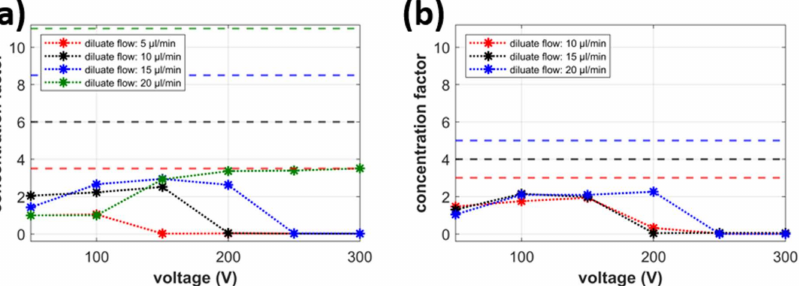
Figure 4. Concentration factor (solid lines with markers) and theoretical concentration factor (dashed lines); ( a ) voltage dependence ( V C = 2 µ L/min), ( b ) voltage dependence ( V C = 5 µ L/min).